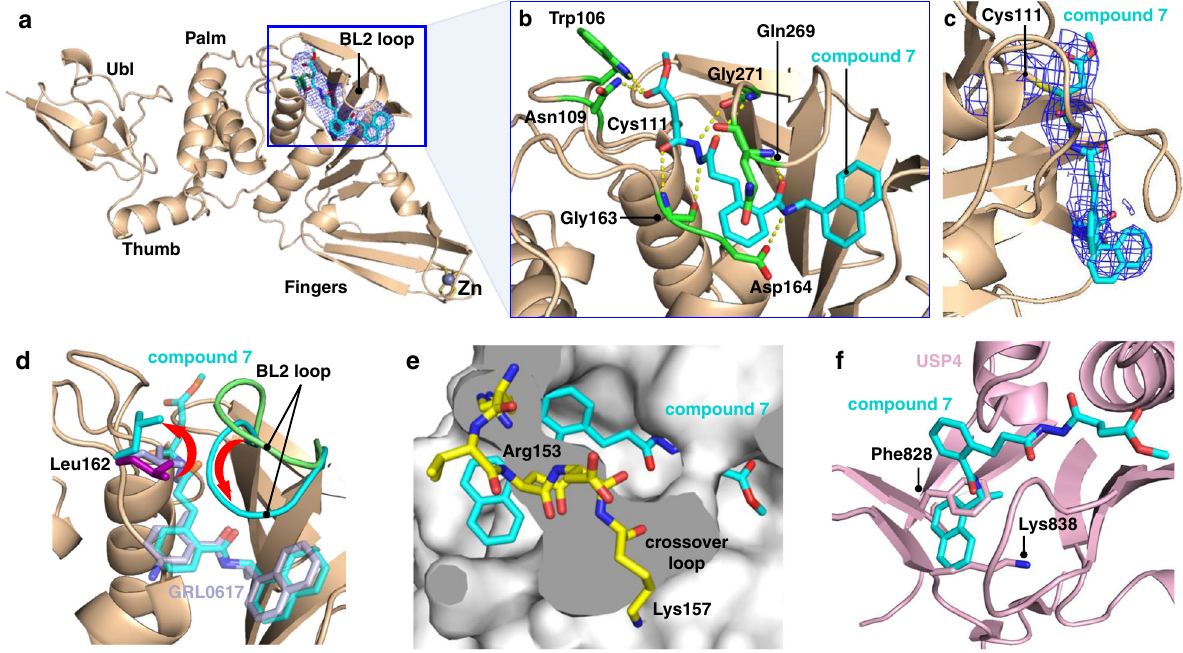
Fig. 7 | Crystal structure of SARS-CoV-2 PLpro in complex with covalent inhi- bitor7.a Overallstructure.Theelectrondensityfor 7 isshowninbluemesh(Fo-Fc omit map contoured at 1.5 σ ). b Interactions between binding site residues (green sticks) and 7 (cyan sticks). c Composite omit map ( σ =1.0) showing the electron density for the covalent bond between Cys111 and 7 . d Superposition of selected structureshighlightingthepositionsofthesidechainofLeu162(sticks)andtheBL2 loop(cartoon)intheabsenceandpresenceofselectedinhibitors:Ligand-free(PDB entry 6W9C, light green), glycerol-bound (PDB entry 6WZU, purple), GRL0617- bound (PDB entry 7CMD, light purple), and compound 7 -bound (this work; cyan).